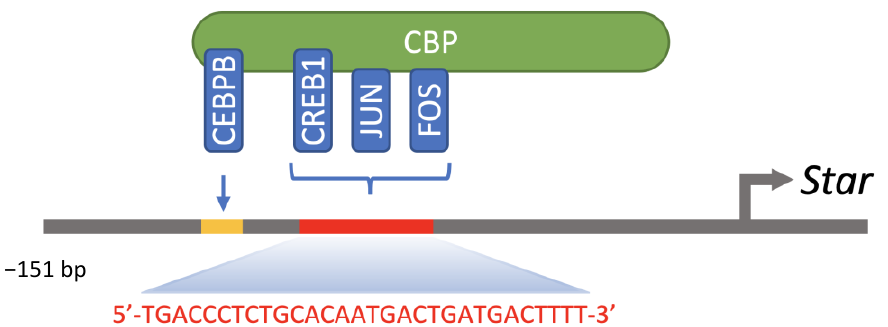
Figure 4. Overview of bZIP transcription factors recruited to the proximal region of the Star promoter. CEBPB is recruited to its regulatory element between − 117 and − 108 bp (5 (cid:48) -ATGAGGCAAT-3 (cid:48) ), whereas CREB1, JUN and FOS form homo- or heterodimer competing for binding to the − 96 to − 67 bp region.